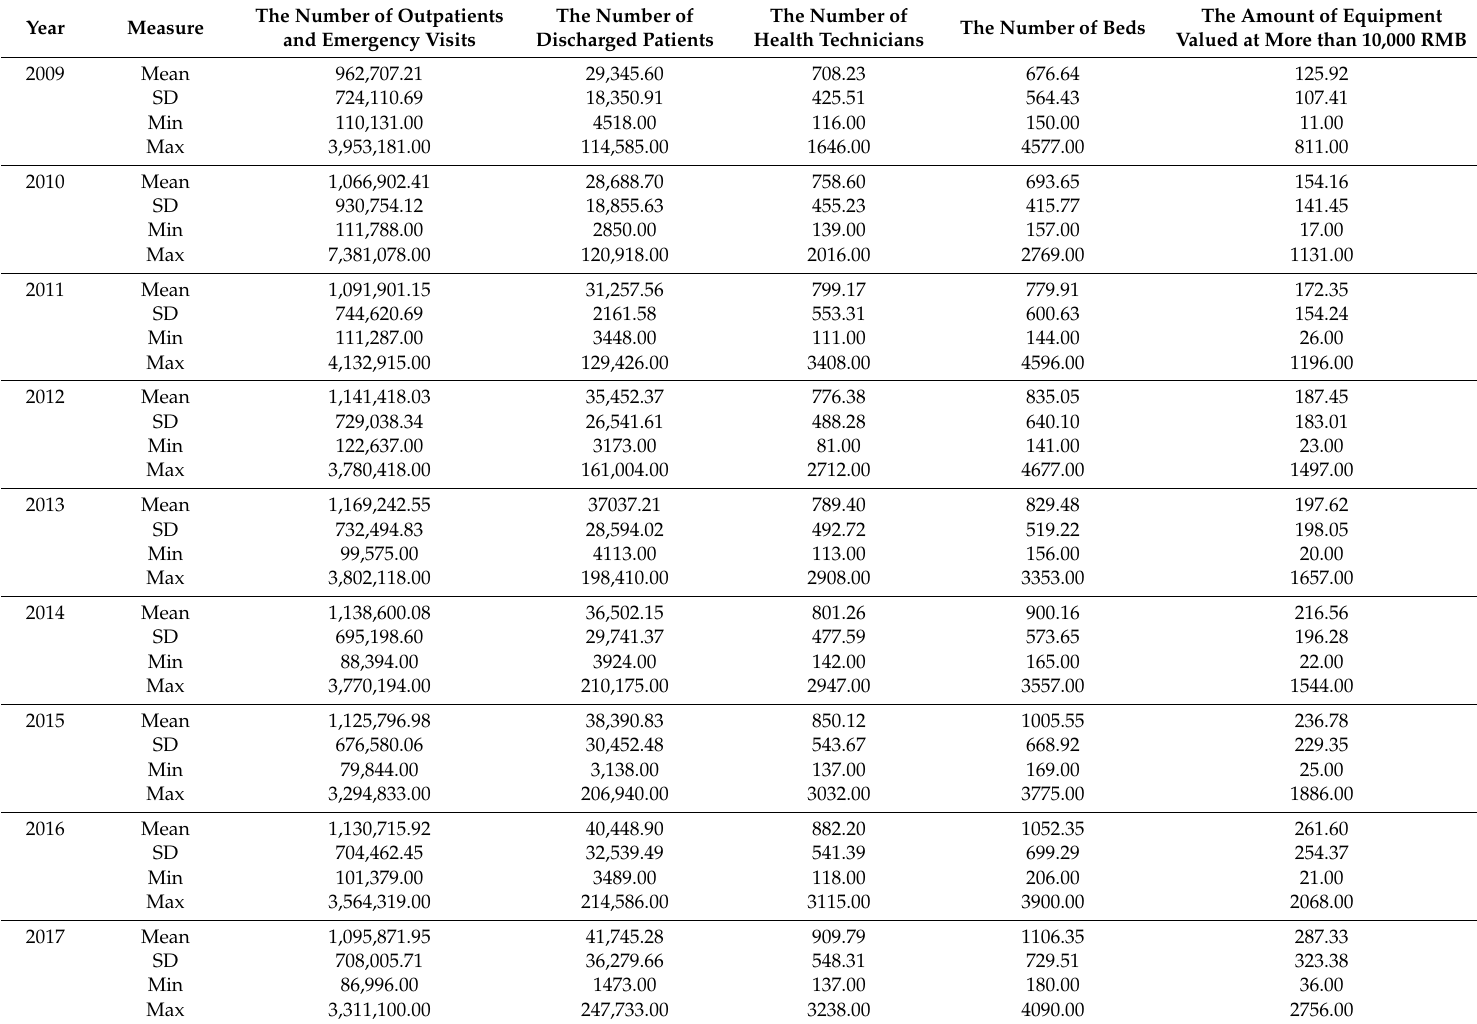
Table 2. Descriptive statistics of inputs and